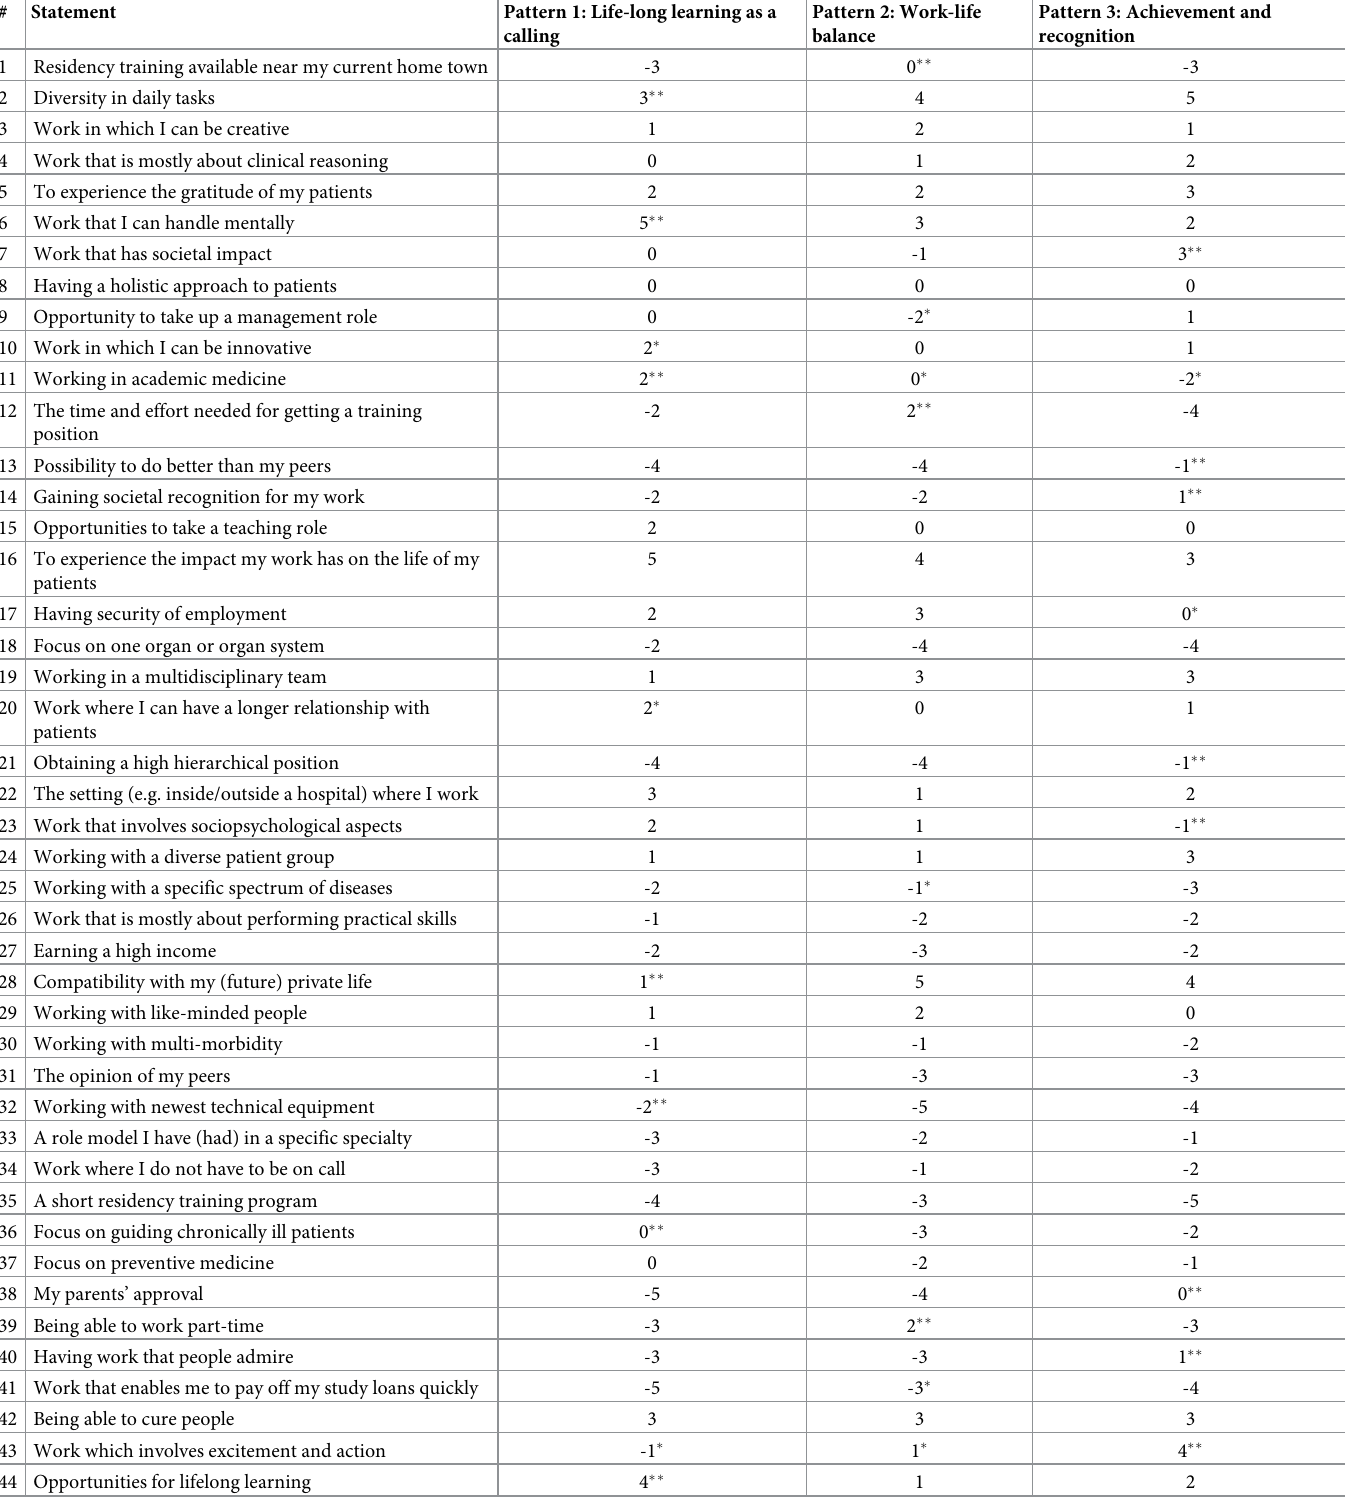
Table 2. Idealised rankings of the